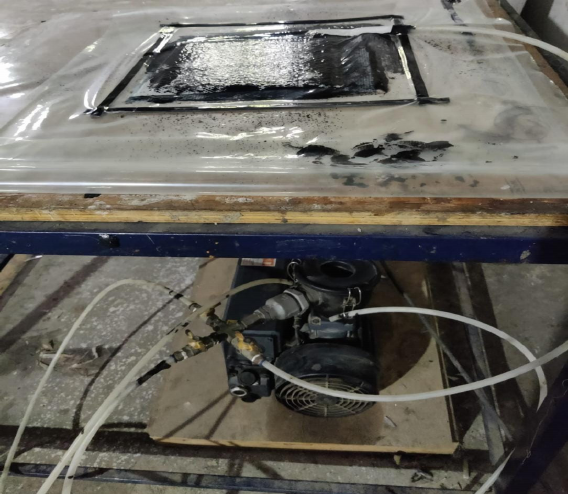
Figure 2. Vacuum infusion process.